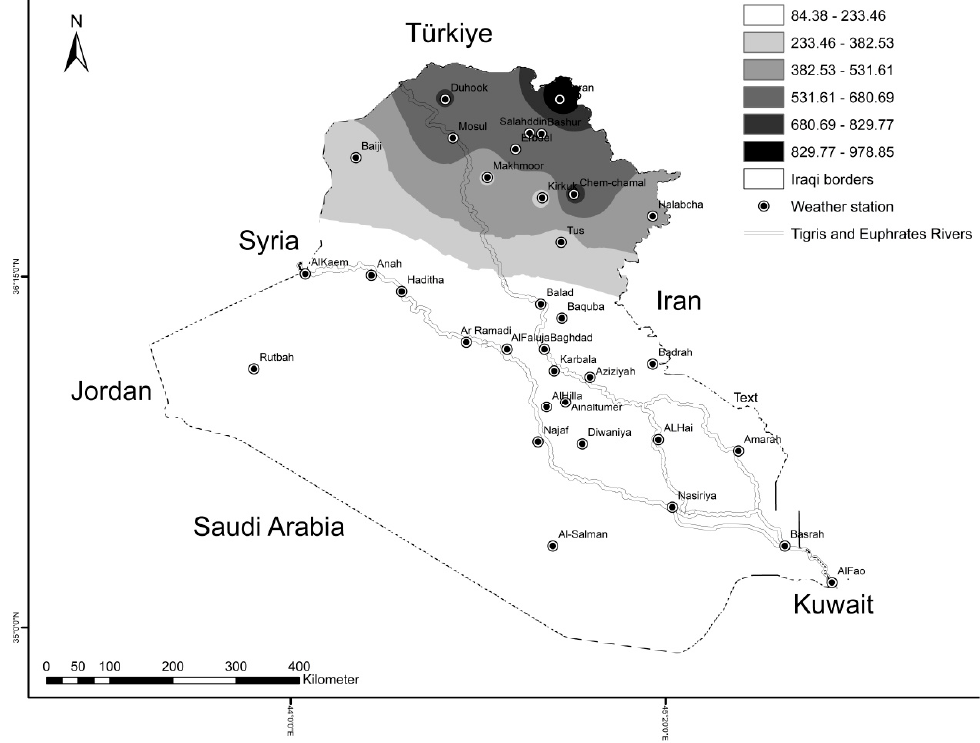
Figure 4. The long-term spatial distribution of the annual precipitation over Iraq.